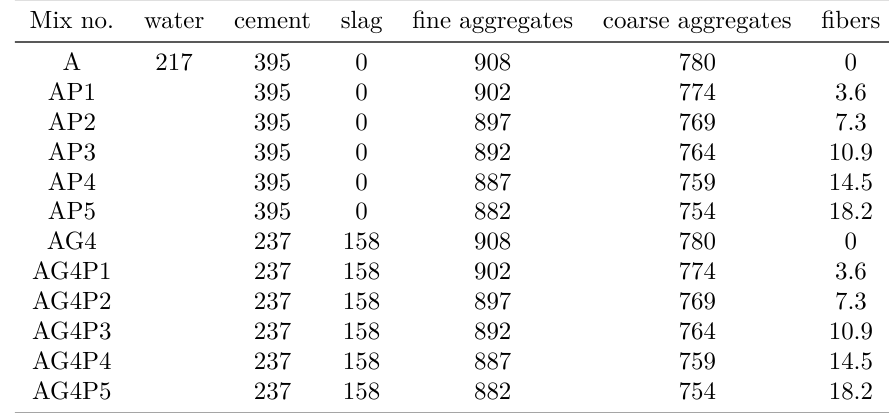
Table 2. Mix design of concrete (kg/m 3 ).